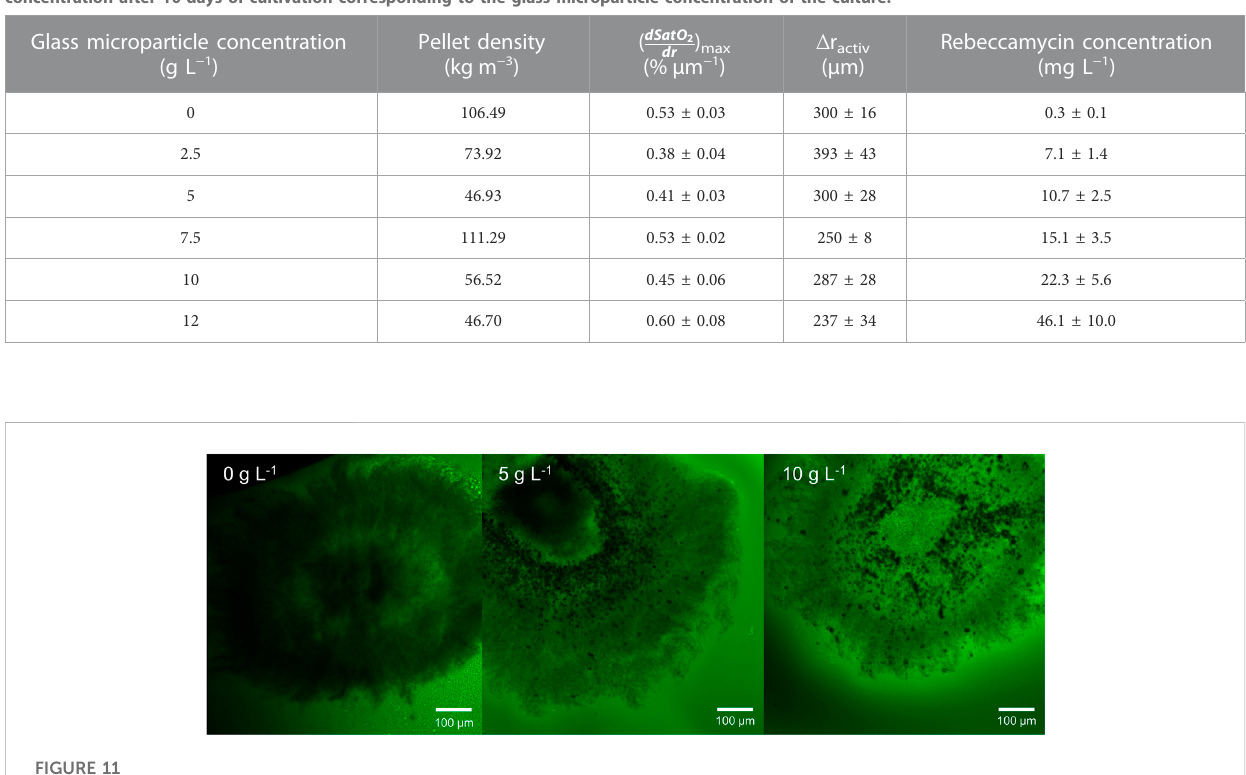
FIGURE 11 ExemplarymicroscopicimagesofslicedpelletsfromanunsupplementedcontrolcultureandMPECsupplementedwithglassmicroparticles(x_50= 7.9 µm) at concentrations of 5 and 10 g L − 1 . Staining was performed with dextran fl uorescein (10,000 Da). Green areas represent low hyphal